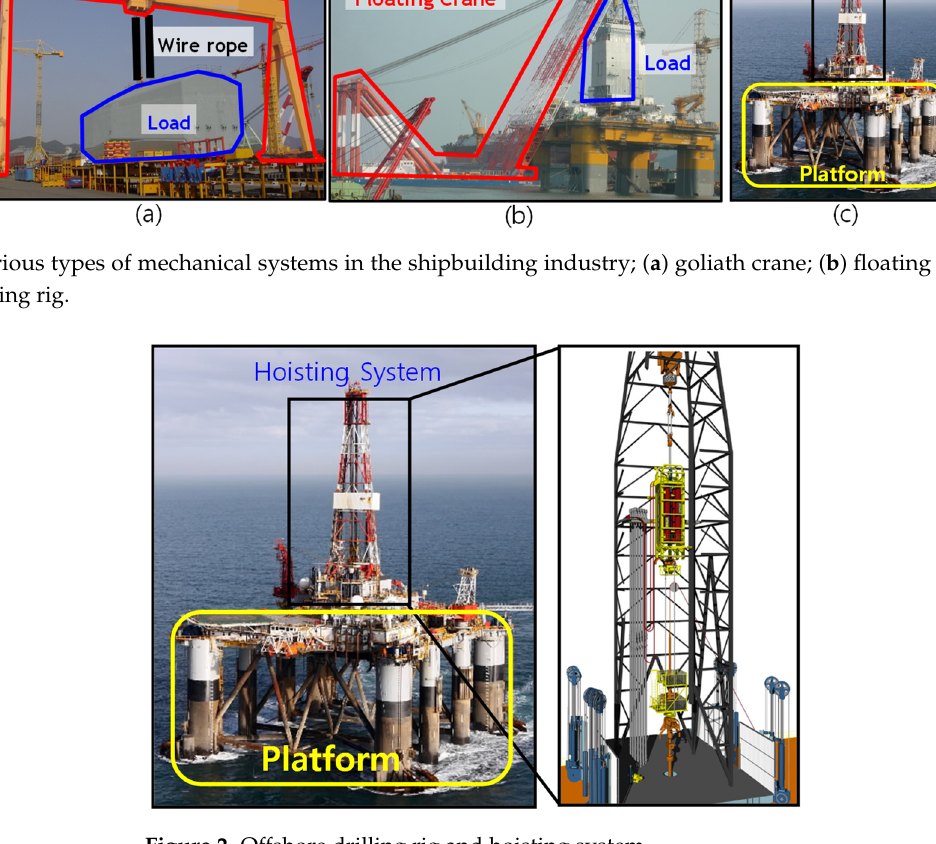
Figure 2. Offshore drilling rig and hoisting